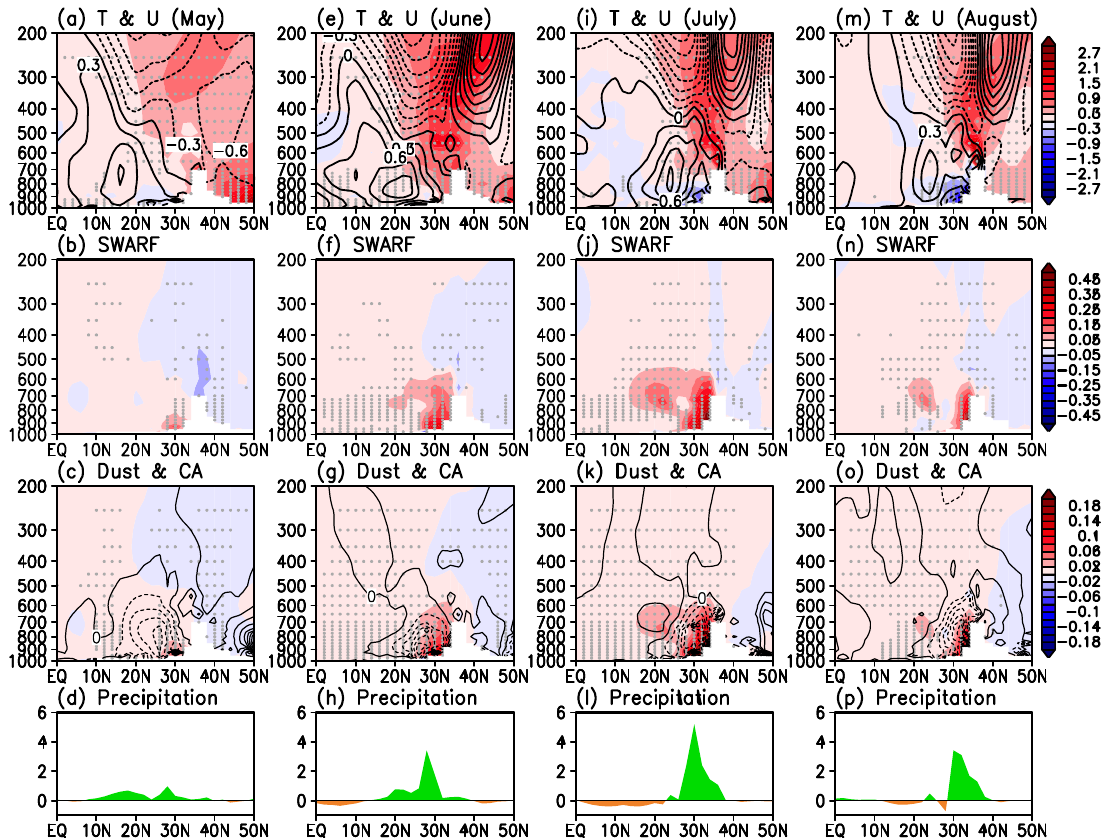
Figure 3. Height–latitude cross-section along 70–90 E, showing anomalies in ( a ) temperature ( ◦ C, shaded) and zonal winds (m s − 1 , contoured), ( b ) atmospheric heating by shortwave radiation ( ◦ C day − 1 ), ( c ) concentration of dust (color-shaded in mg Kg − 1 ) and carbonaceous aerosols (CAs) (contoured with negative values dashed, in g Kg − 1 ), and ( d ) precipitation (mm day − 1 ) during May. Panels ( e – h ) are the same as ( a – d ), except for June. Same for ( i – p ), except for July and August, respectively. Grey dots indicate 95% statistical confidence level. SWARF: shortwave aerosol radiative forcing.